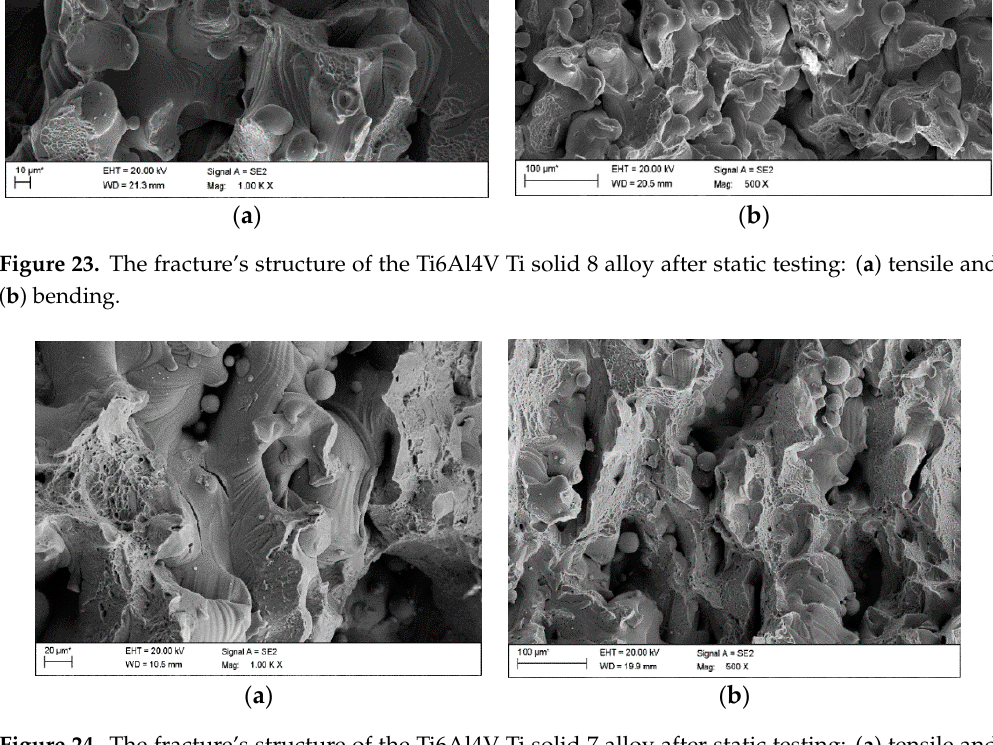
Figure 24. The fracture’s structure of the Ti6Al4V Ti solid 7 alloy after static testing: ( a ) tensile and ( b ) bending.